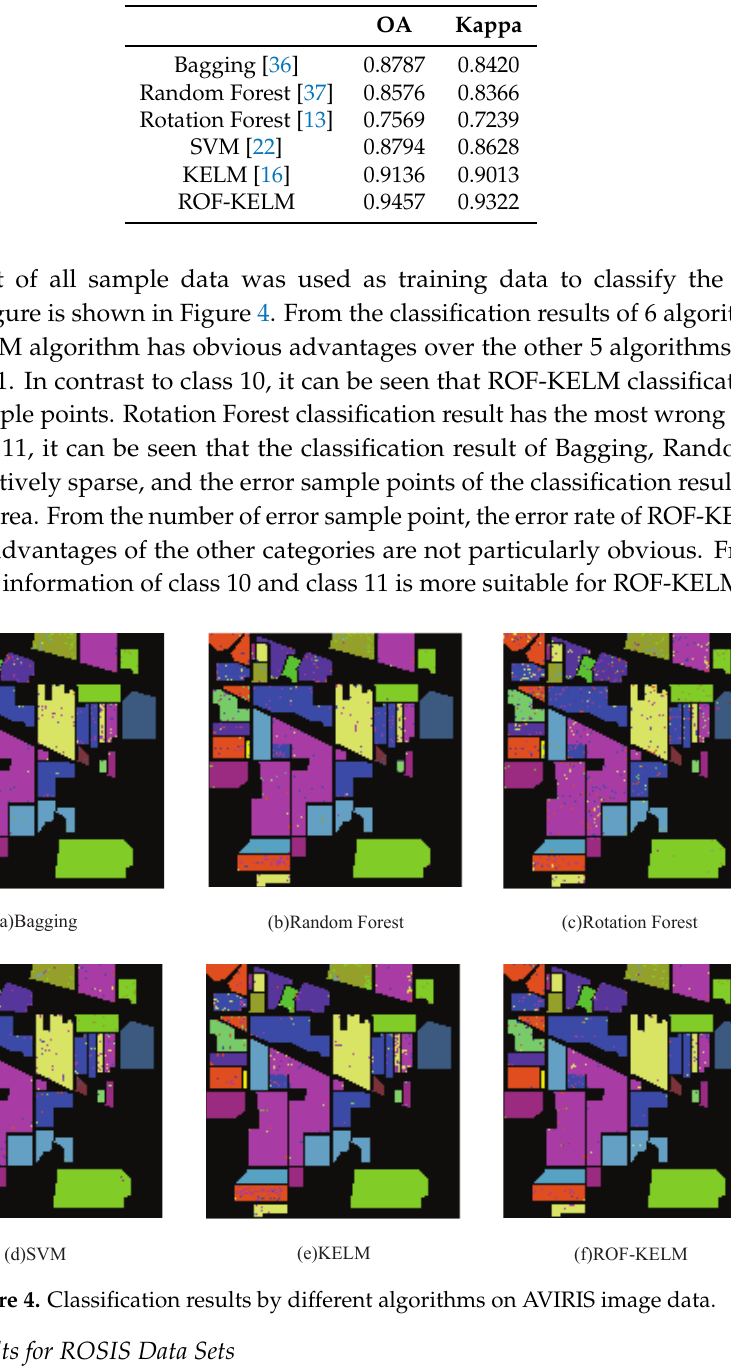
Table 2. The OA and Kappa comparison of AVIRIS image data classification.